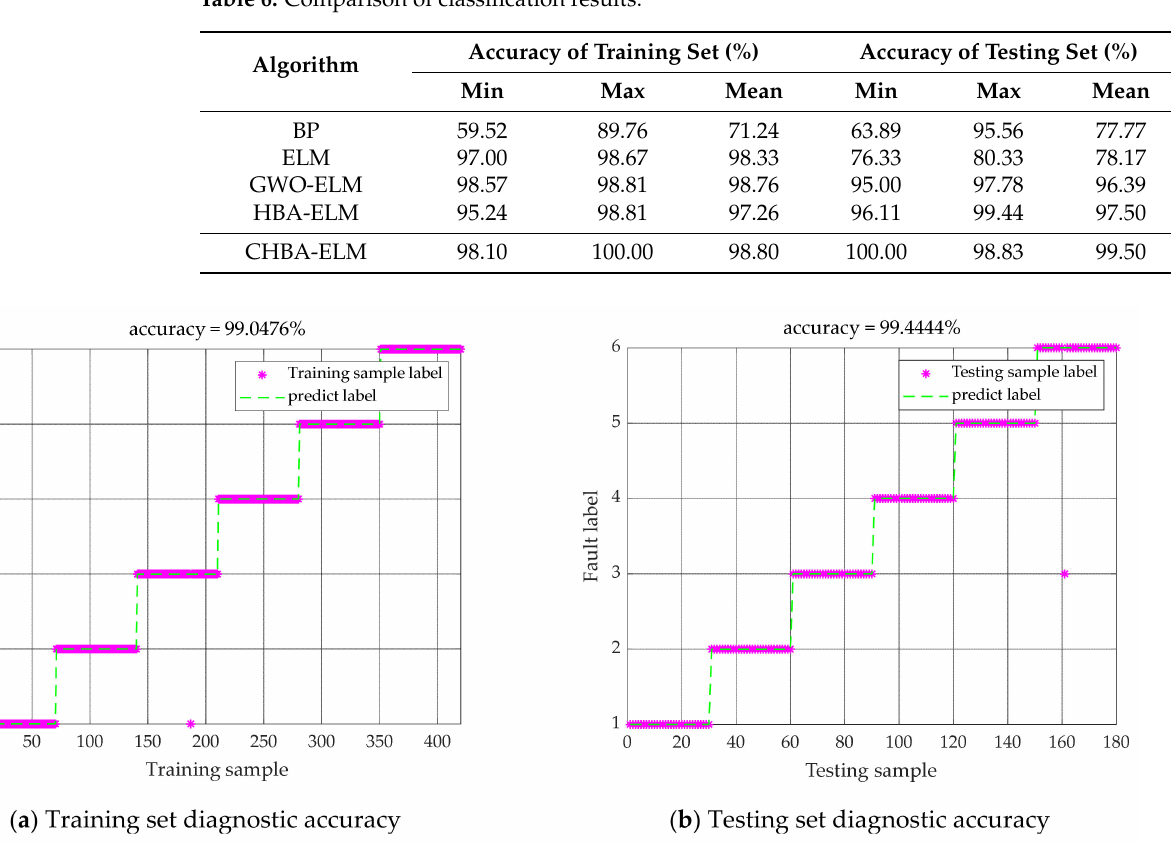
Table 6. Comparison of classification results.